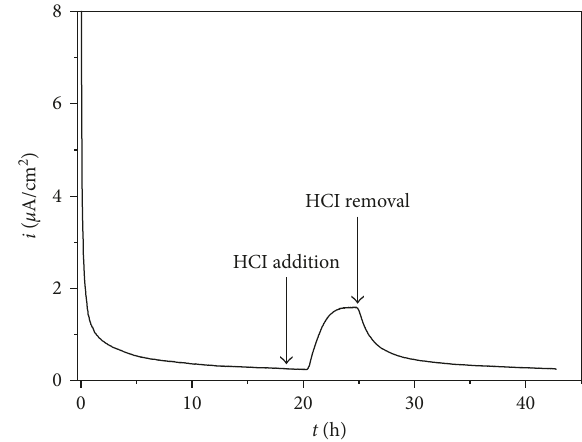
Figure 4: The polarisation curve of carbon steel S253 in 0.2M NaOH at 20 ° C.